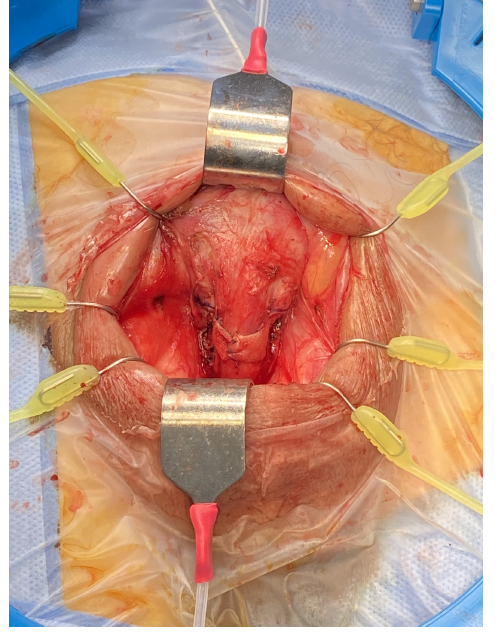
Figure 2. Bilateral corpora cavernosa sutured in the midline.